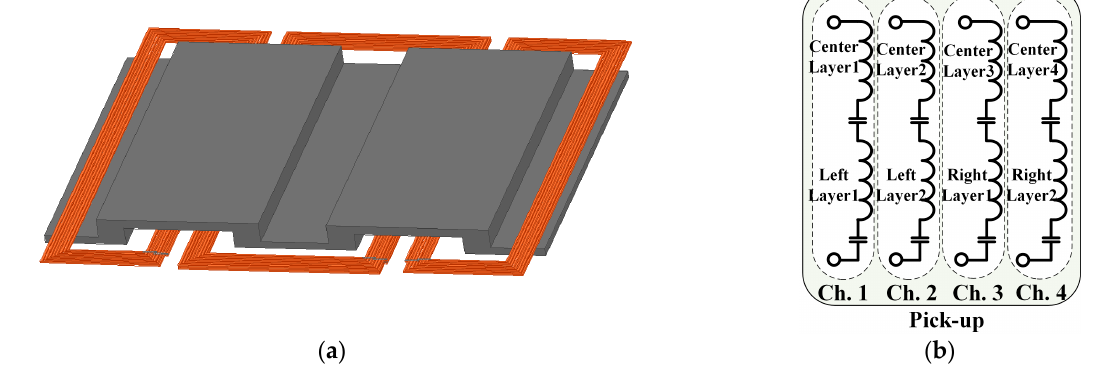
Figure 5. Designed receiver coil and its winding and tuning method for flux augmentation and voltage suppression: ( a ) a schematic of the designed receiver coil; ( b ) distributed tuning method of the receiver coil.